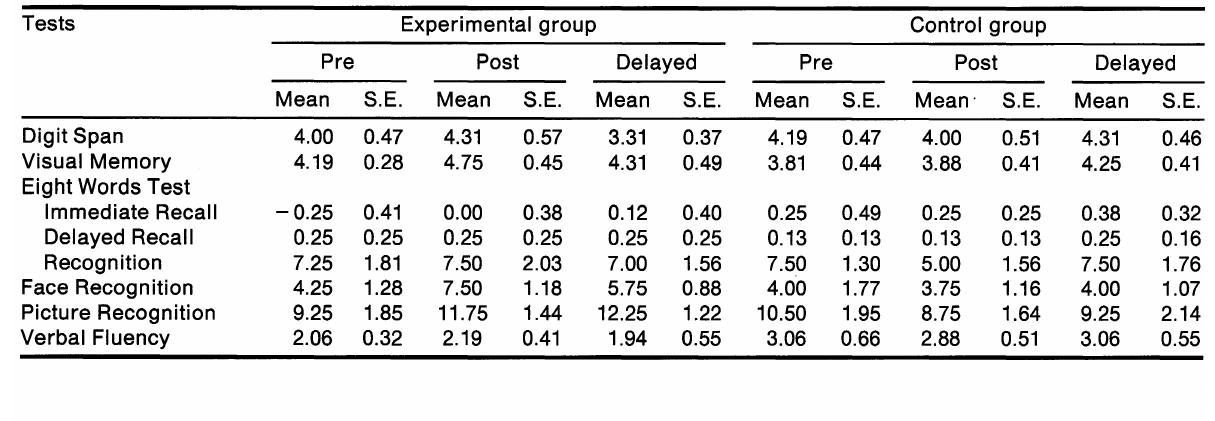
TABLE III. Results of the Group by Time interaction effects of the pre/post (T1/T2) analyses of variance. and the paired t-test post-hoc comparisons for the significant